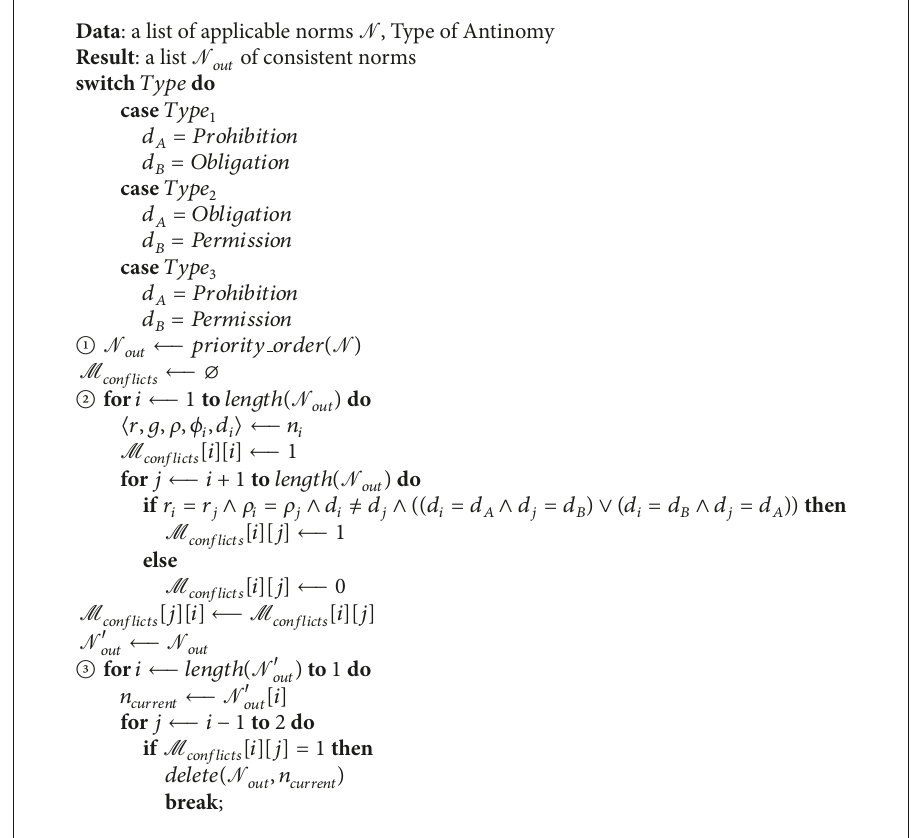
Data : a list of applicable norms N , Type of Antinomy Result